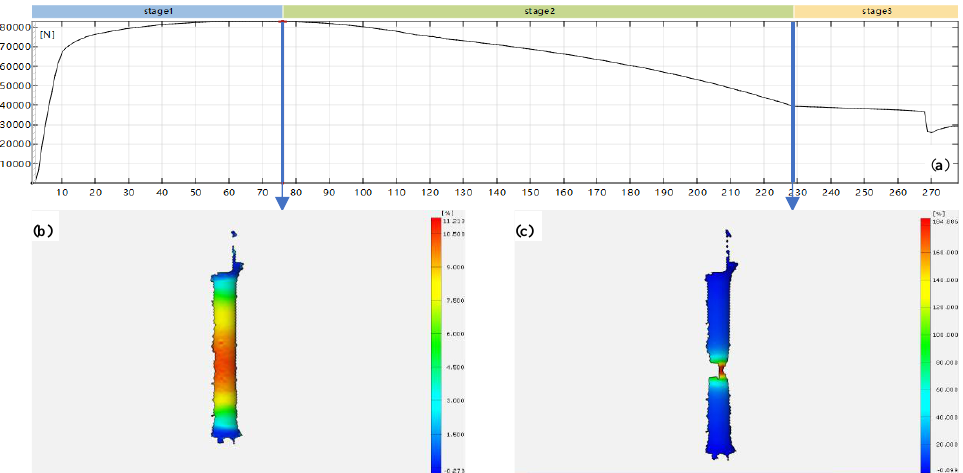
Figure 3. Tensile test result of pipe metal by DIC. ( a ) Load-number of image frames curves; ( b ) The cloud picture of tensile strain at the end of stage 1; ( c ) The cloud picture of tensile strain at the end of stage 2.